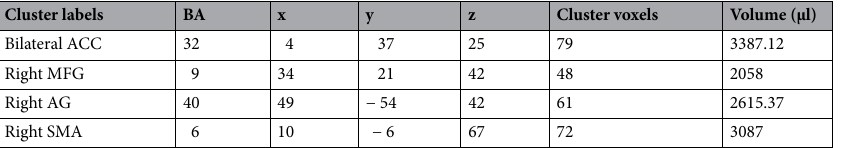
Table 3. Centromedial amygdala (CMA): areas of negative association of CMA connectivity with PTSD group CTQ scores. BA brodmann area, ACC anterior cingulate cortex, MFG middle frontal gyrus, AG angular gyrus, SMA supplementary motor